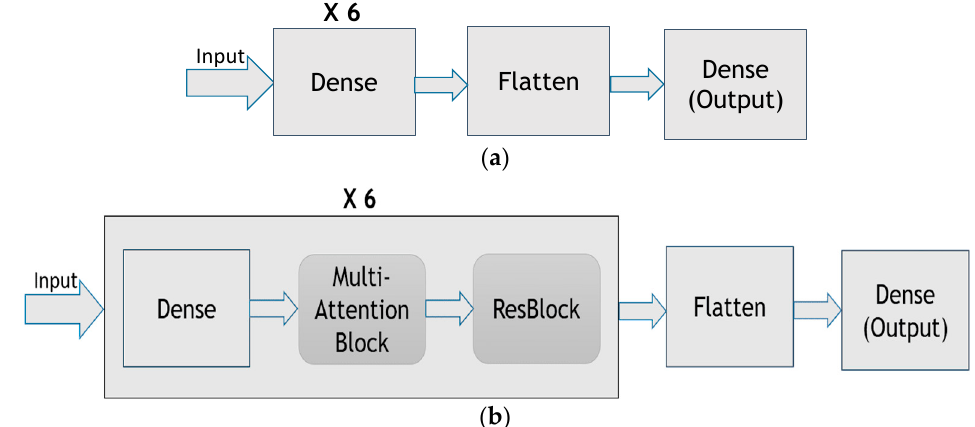
Figure 9. ( a ) The DNN without multi-attention blocks or residual blocks, ( b ) the DNN with multi- attention blocks and residual blocks adopted by the proposed method.